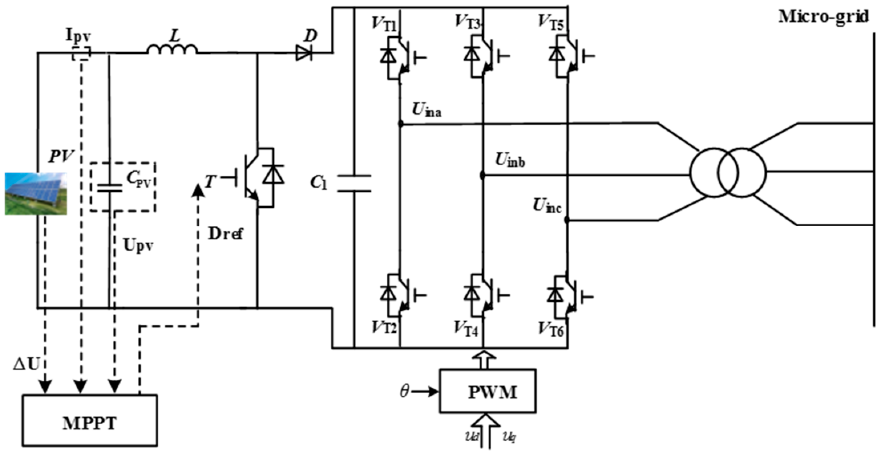
Figure 3. Schematic configuration of a grid-connected PV generation unit for the micro-grid. MPPT, maximum power point tracking.